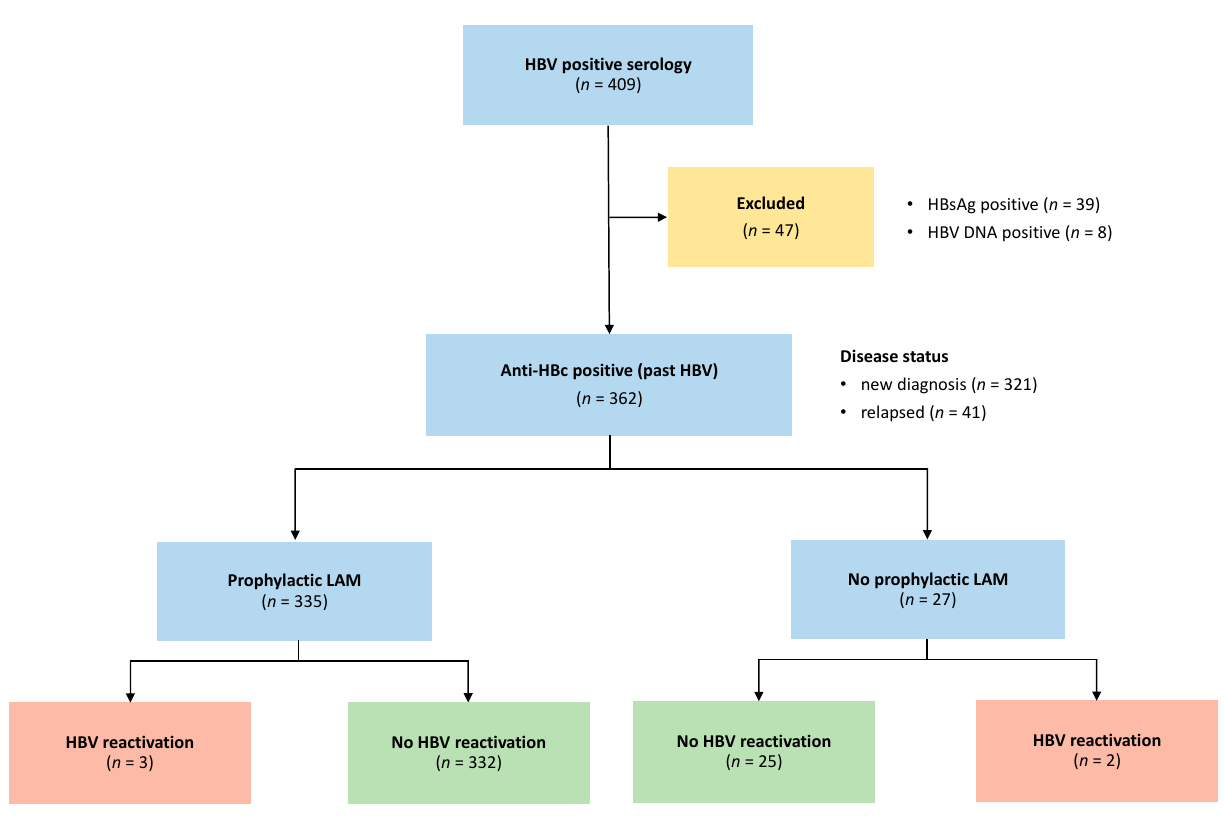
Figure 1. Study flow chart. HBV = Hepatitis B Virus; HBsAg = HBV surface antigen; anti-HBc = antibody to HBV core antigen; LAM = lamivudine. Table 1. Baseline characteristics of patients with past HBV infection ( n = 362). *